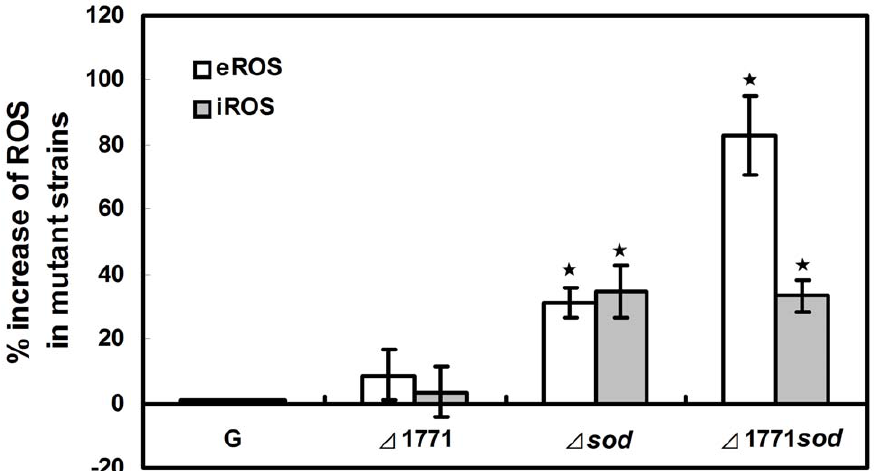
Figure 4. ROS assayed by chemiluminescence in planktonic cells of different L.monocytogenes strains. Percentages of extracellular (open bars) and intracellular (grey bars) increase of ROS generated in mutants compared to the wild type (WT) L. monocytogenes 4b G. The relative percentages in mutants were calculated as follows: (mutant OD 575 -WT OD 575 )/WT OD 575 . Cells were cultured in TSB with shaking (180 rpm) overnight to stationary phase, production of ROS by 10 9 bacteria. The experiments were repeated three times and error bars indicate the standard deviations. Stars indicate that changes were significantly different ( p -value , 0.05, n=3).